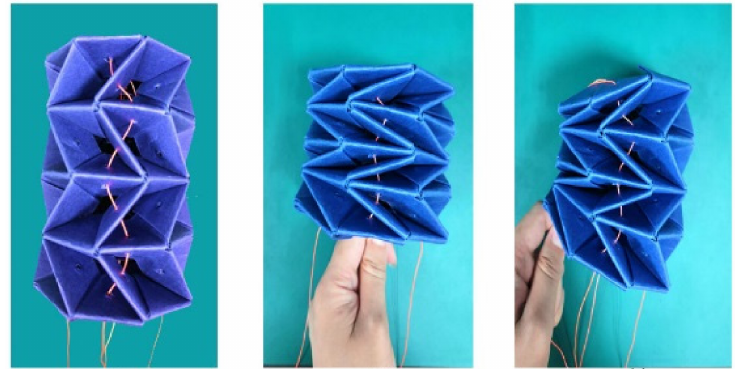
Figure 11. Extension/contraction and bending motions of a twisted tower structure.